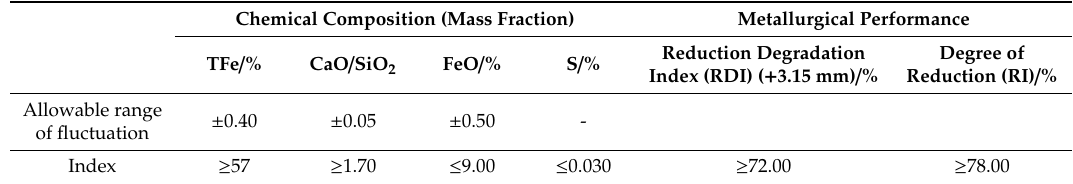
Table 6. Technical specifications of high-qualitied iron sinter